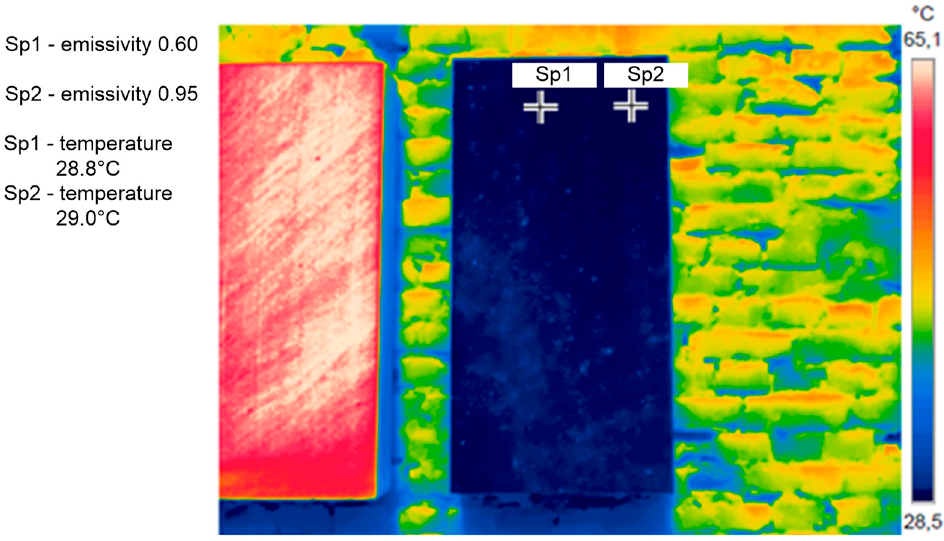
Figure 1. Test thermogram of white polystyrene board with two measurement points.